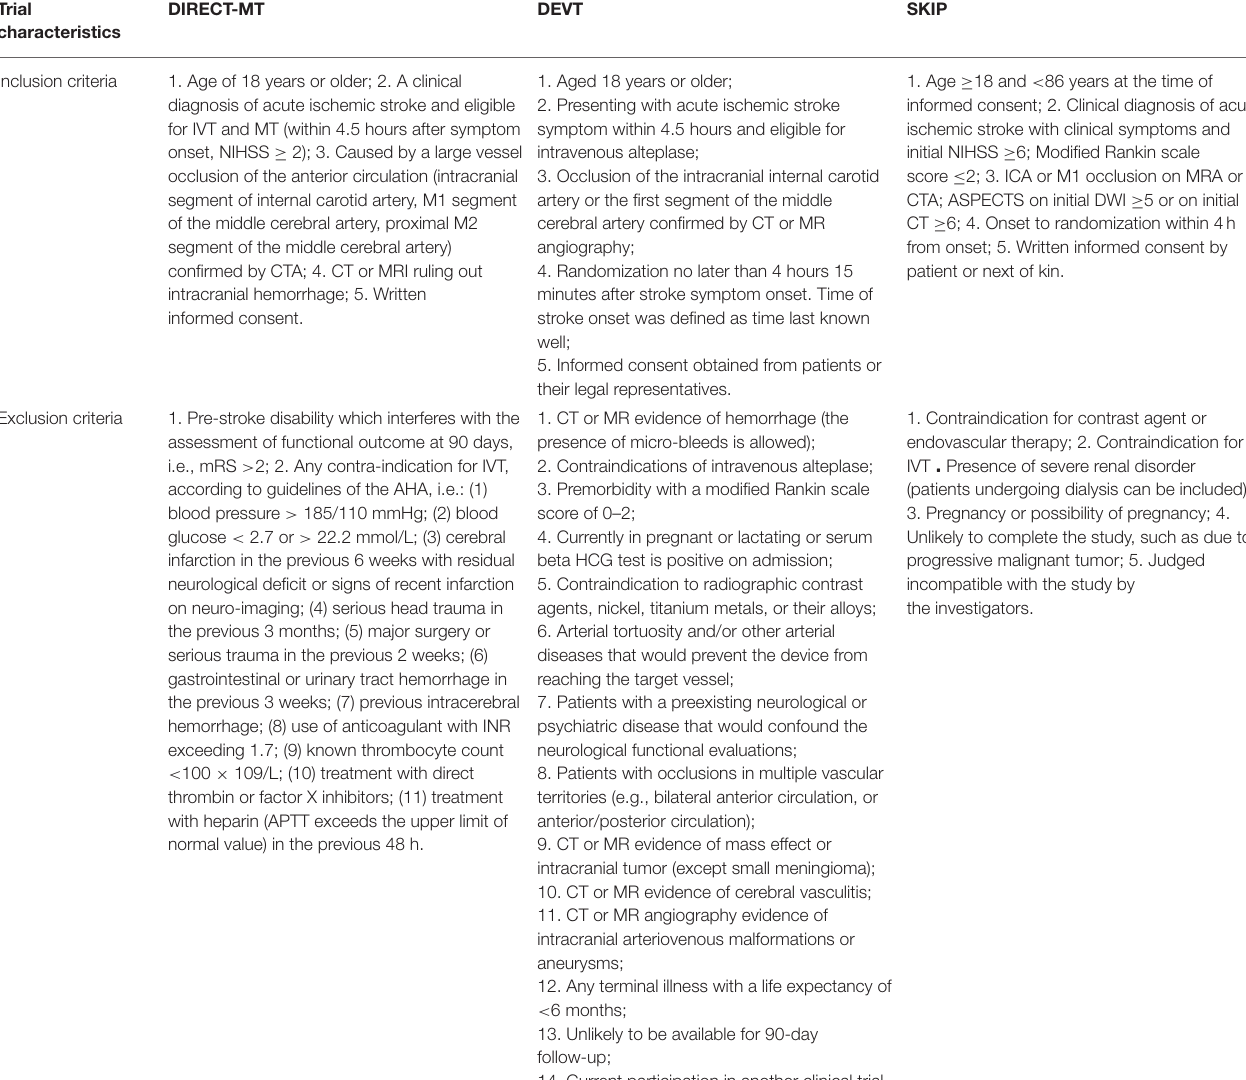
TABLE 1 | Characteristics of studies included in